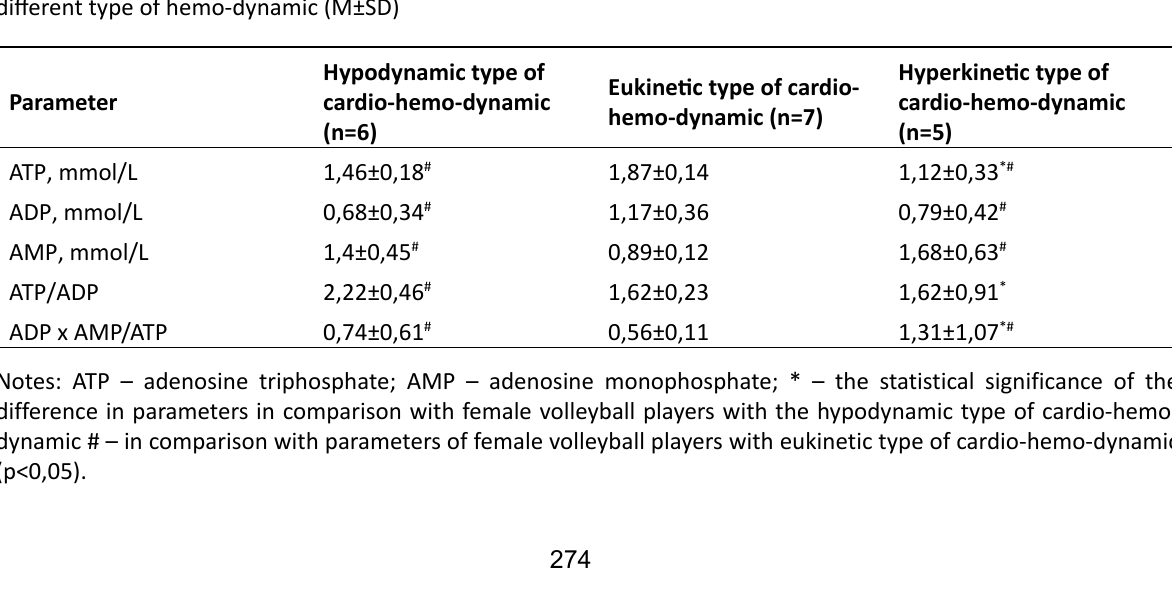
Table 1. The contents of adenylic nucleotides in erythrocytes of peripheral blood in female volleyball players with different type of hemo-dynamic